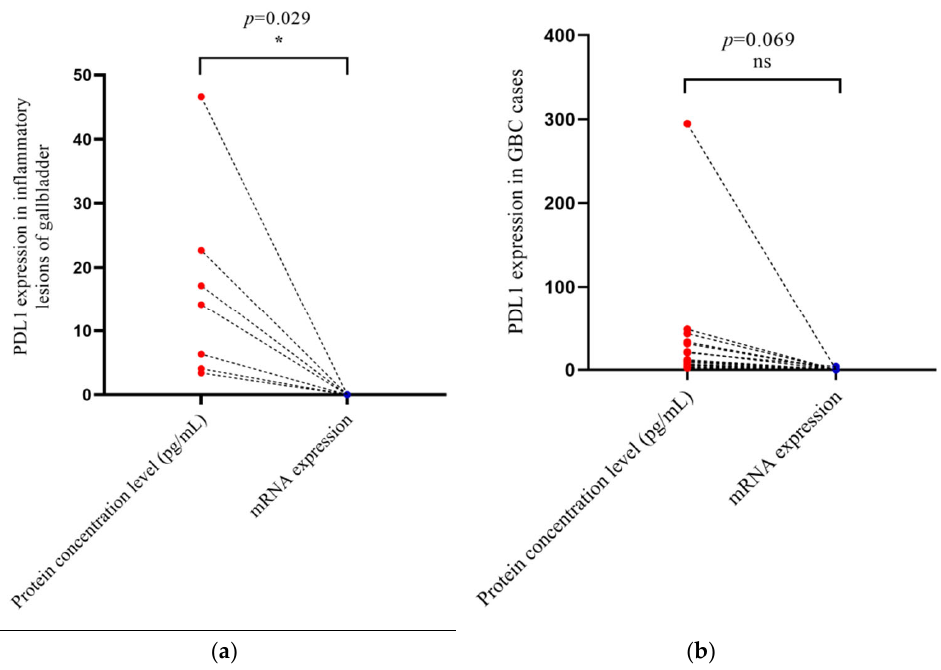
Figure 3. ( a ) PDL1 protein concentration level and its relative mRNA expression in inflammatory lesions ( n = 7), ( p = 0.029); ( b ) PDL1 protein concentration level and its relative mRNA expression in cancer cases ( n = 17), ( p = 0.069). The red color dot represents protein concentration in individual cancer cases and the blue color dot represents mRNA expression in individual inflammatory cases of gallbladder.